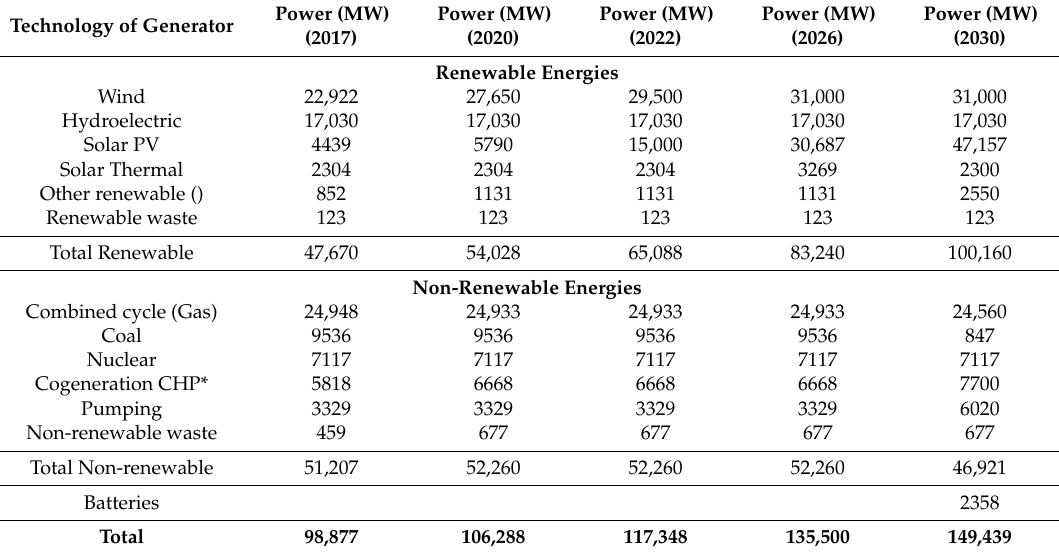
Table 10. Electric power sources in Spain on the Iberian Peninsula until 2030